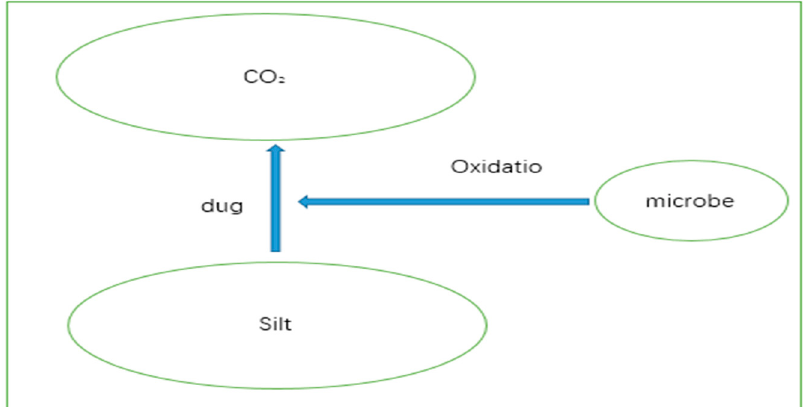
Figure 1. The relationship between sludge mining and carbon dioxide release.